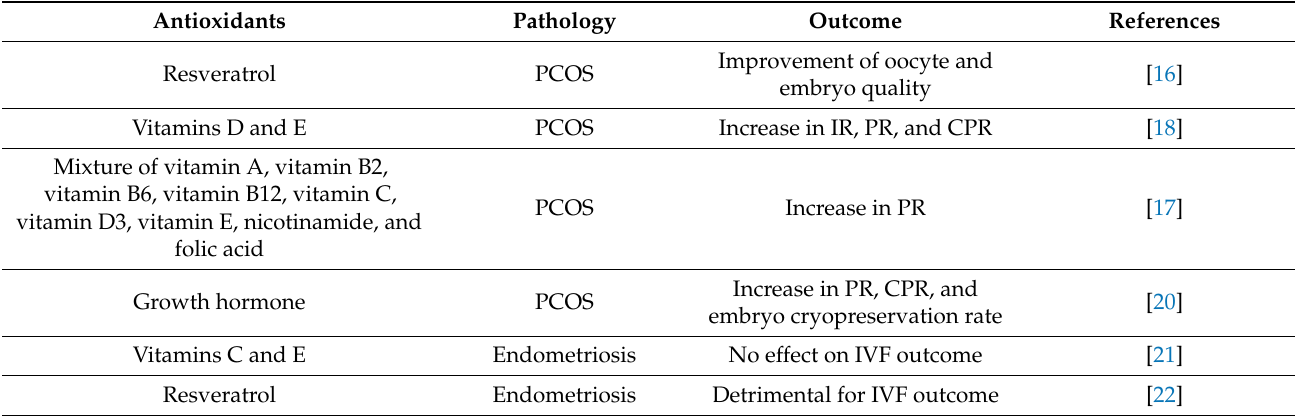
Table 1. Antioxidants in the treatment of ovarian factor in young